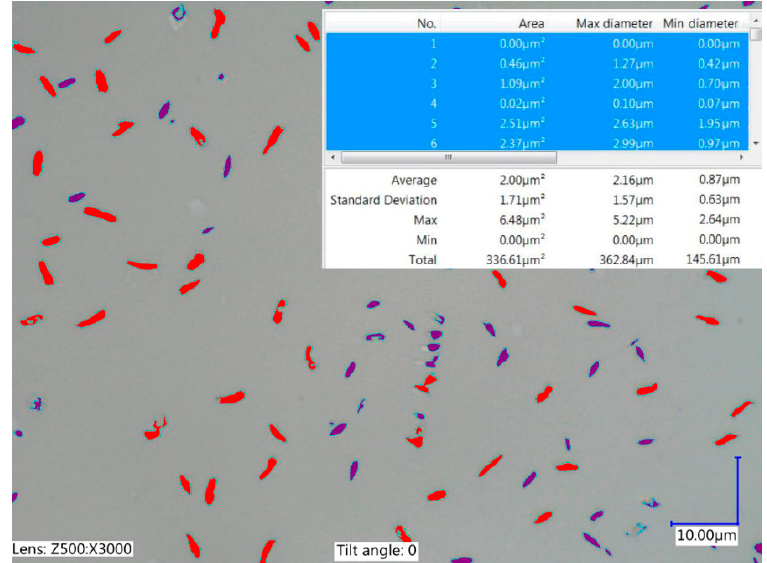
Figure 2. Reduced graphene oxide in the dielectric: calculating the average area of RGO.